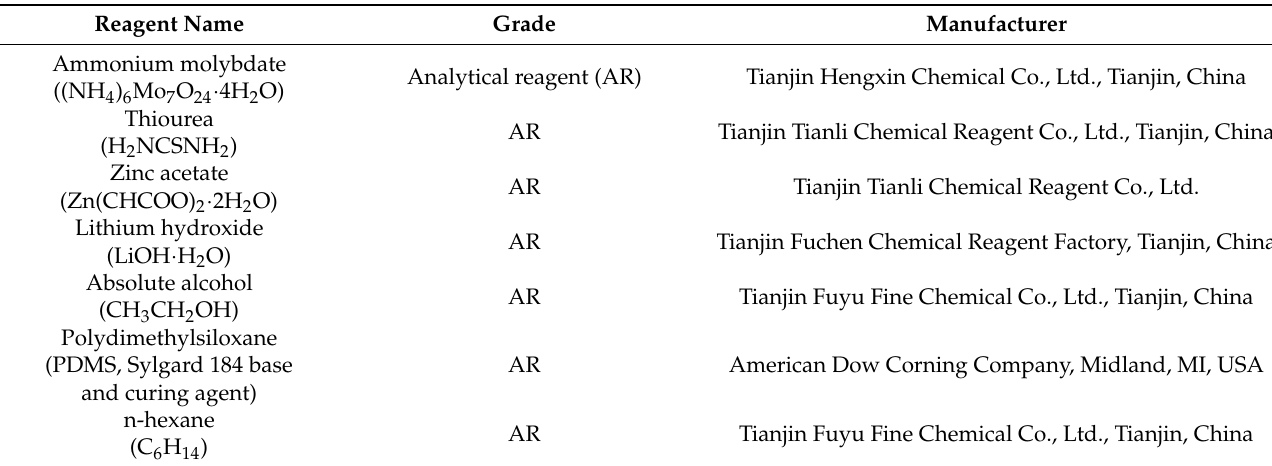
Table 1. Test reagents and